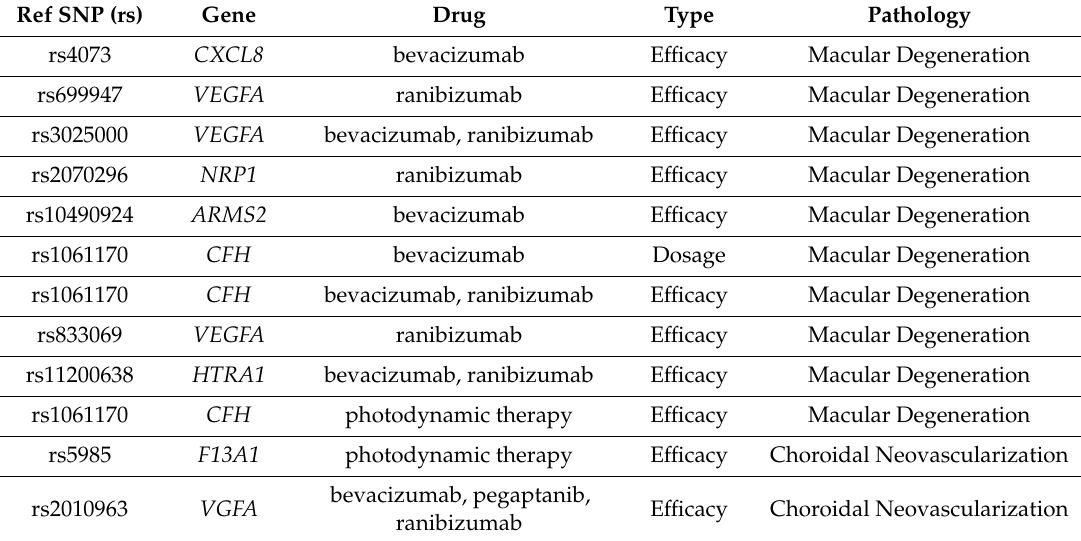
Table 1. Genetic variants a ff ecting drug response in macular degeneration or choroidal vasculopathy (obtained from PharmGKB